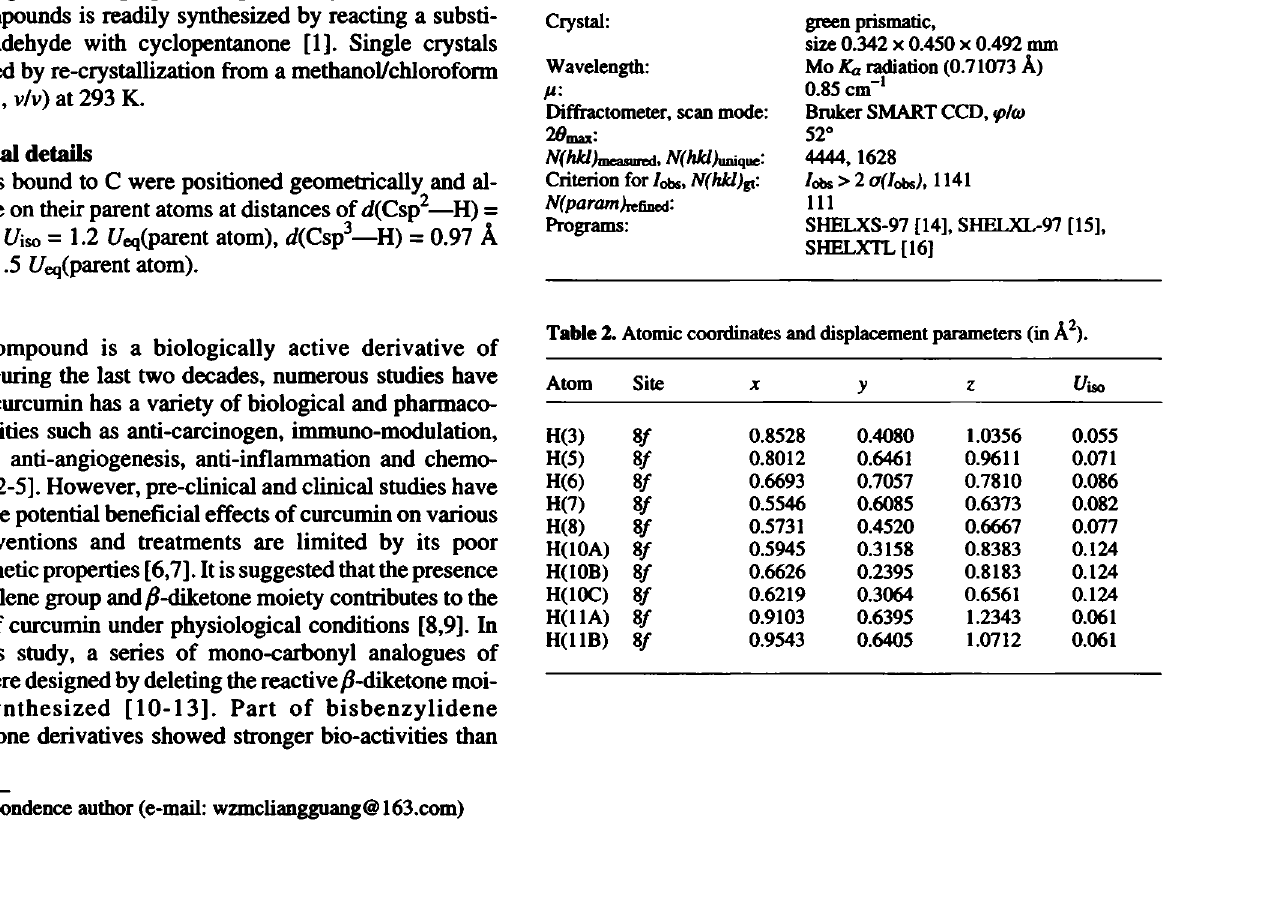
Table 1. Data collection and handling.